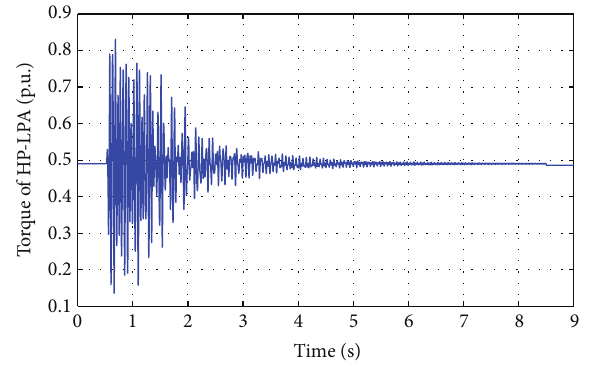
Figure 9: The inhibitory effect of SVC optimized by IBBO algo-